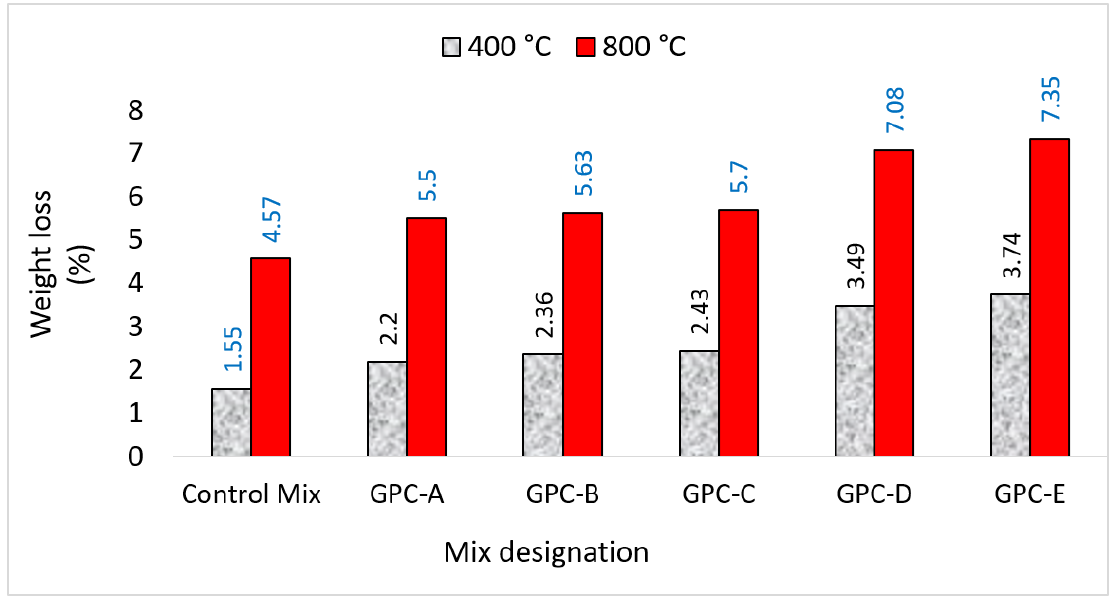
Figure 7. The residual compressive strength of OPC and QFS-GPC specimens after exposure to 400 °C and 800 °C temperatures.